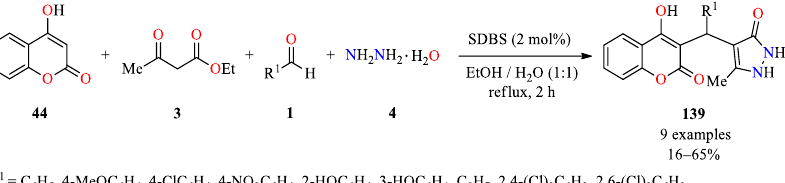
Table 44. Antioxidant activity of dihydropyrano[2,3- c ]pyrazole derivatives 90